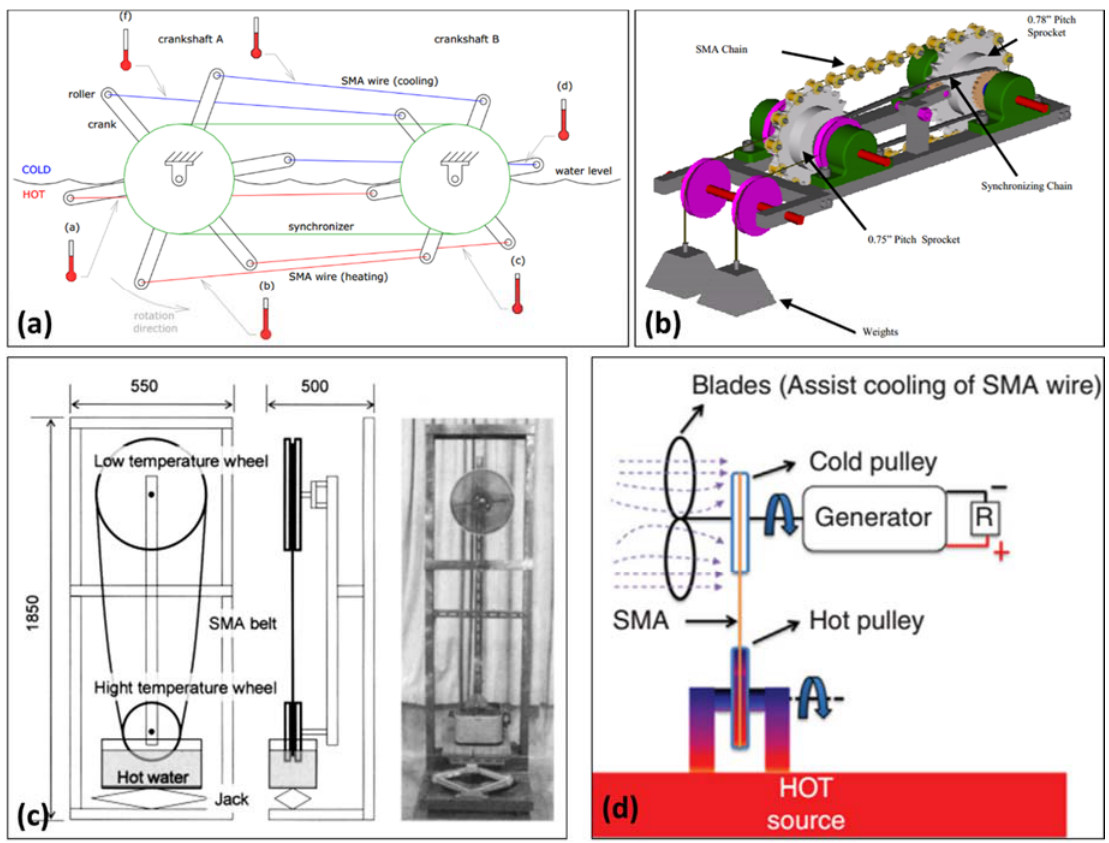
Figure 26. ( a ) Schiller’s SMA engine [217]; ( b ) Wakjira’s SMA engine with driving